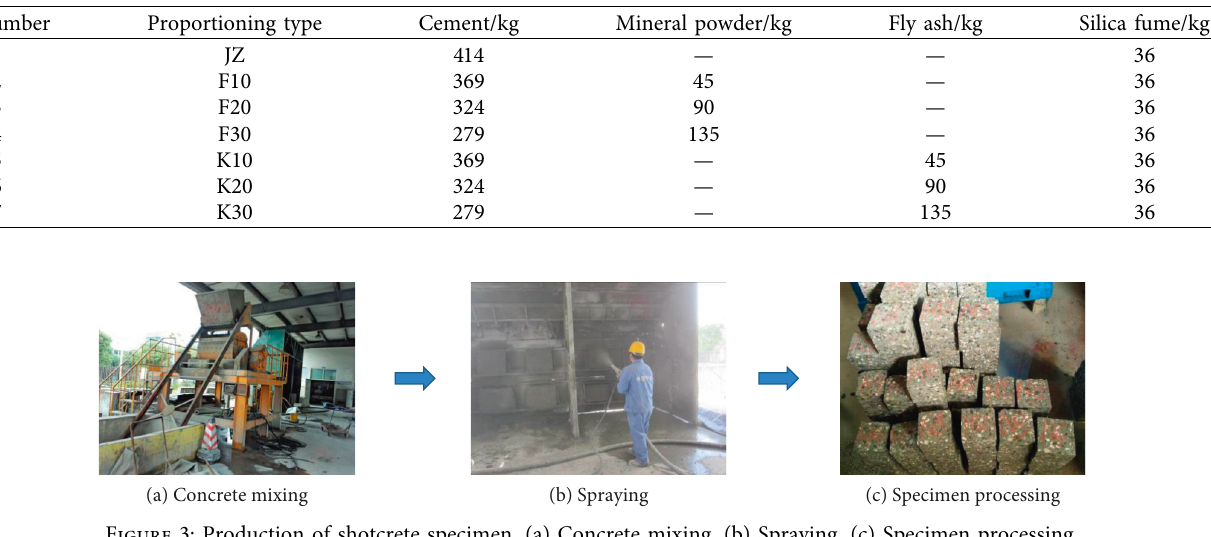
Table 3: Raw materials per cubic meter of C30 shotcrete.